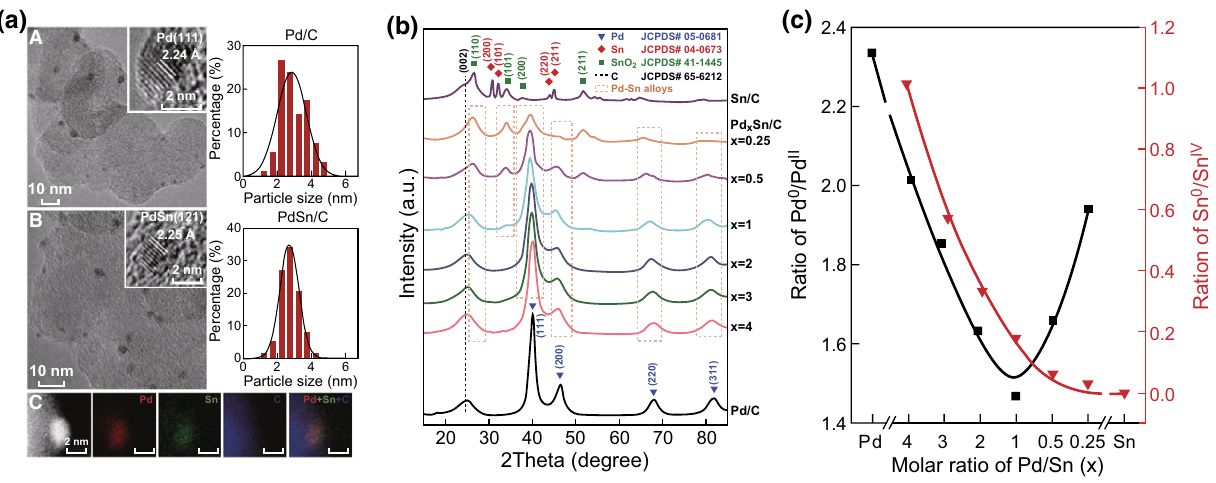
Fig. 5 a TEM images and size distributions of the NPs in Pd/C and PdSn/C. b XRD patterns of the catalysts with different Sn contents. c Rela‑ tive intensity ratios of Pd 0 /Pd II and Sn 0 /Sn IV versus the molar ratios of Pd/Sn. Reprinted with permission from Ref.